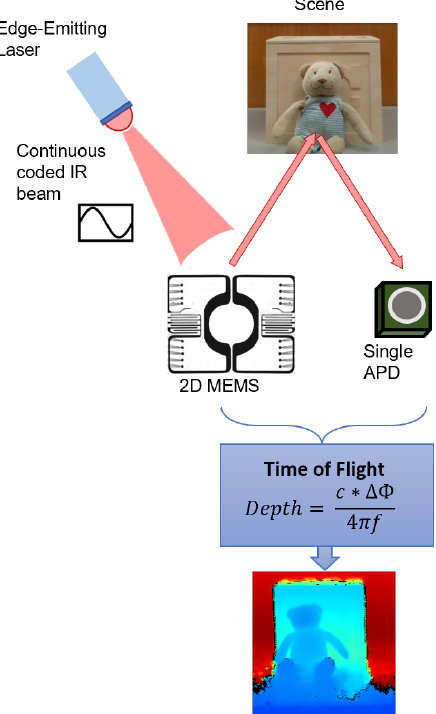
Figure 5. An illustration of the Time of Light technology present in L515 camera: an Edge-Emitting laser (EEL) emits a continuous modulated IR beam that is scanned across the entire FOV through a 2D MEMS mirror. The scene reflects the IR which is received by a single Avalanche Photodiode (APD). The scene depth is estimated by measuring the phase delay between the transmitted and received light